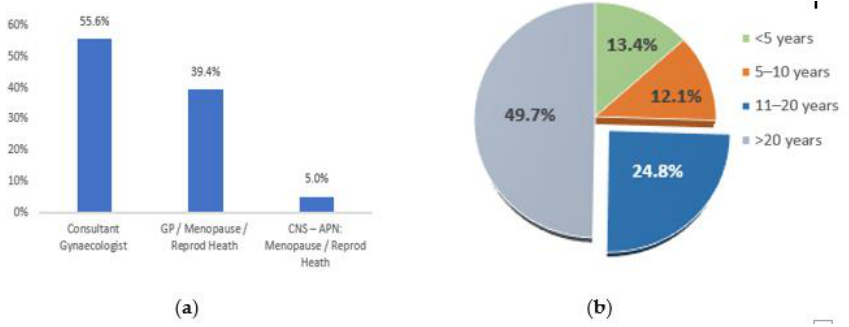
Figure 3 . Grades and experiences of responders to the Survey ( a ) Percentages of different physi- cians / practitioners who responded to the survey; ( b ) Percentages of responders with different years of experience in managing women with surgical menopause after pelvic clearance for endometrio- sis. Abbreviations: GP, General Practitioner; CNS, Clinical Nurse Specialist; APN, Advanced Nurse Practitioner.